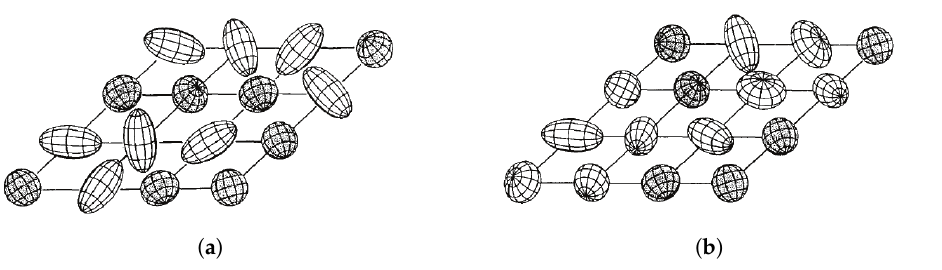
Figure 1. Comparison of orientational glass with quadrupolar glasses. Reproduced with permission from [32]. Copyright Springer Nature, 1996. ( a ) Orientational glass; ( b ) quadrupolar